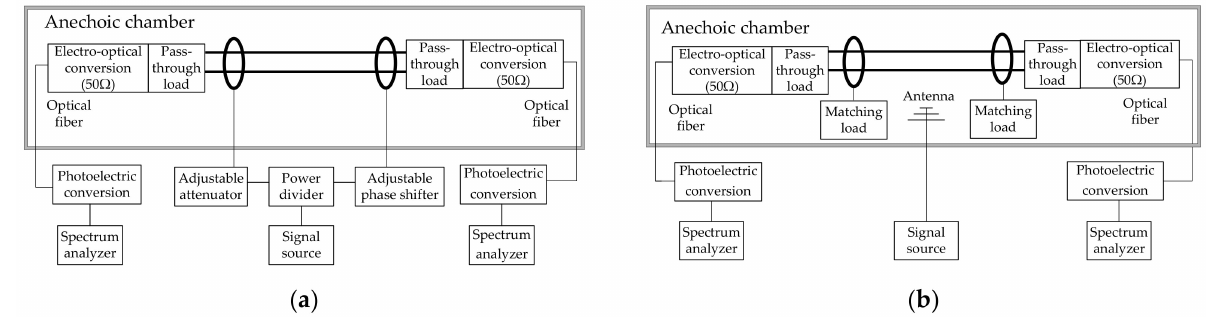
Figure 9. Test configuration: ( a ) injection; ( b )